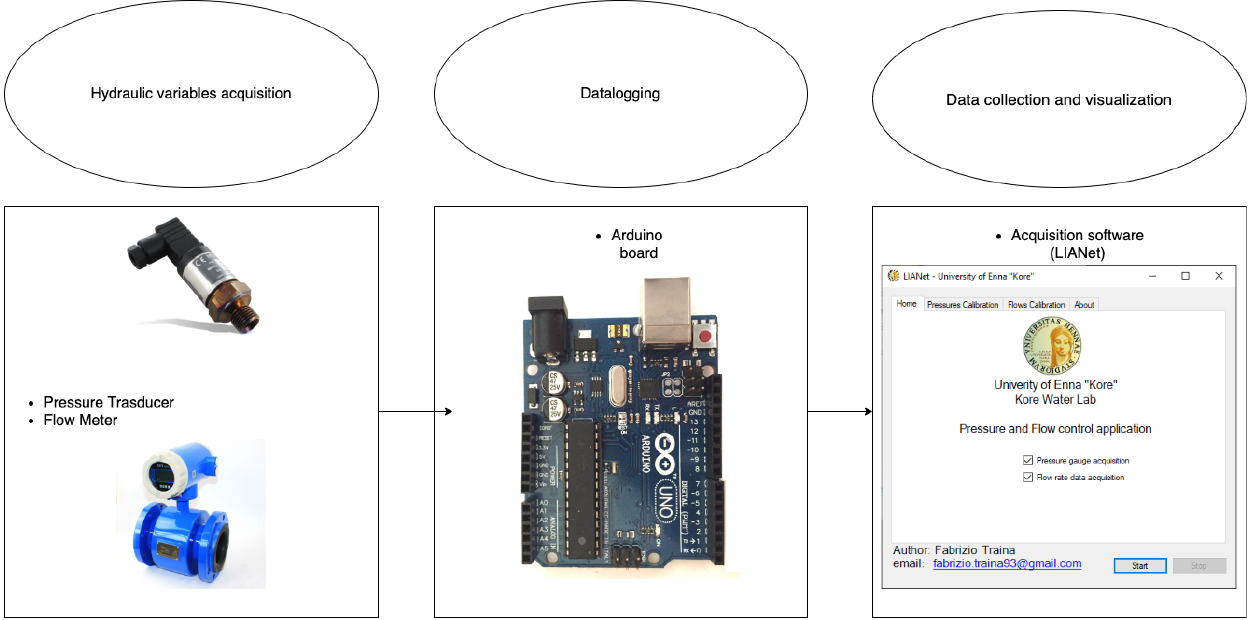
Figure 4. IoT pressure monitoring system.